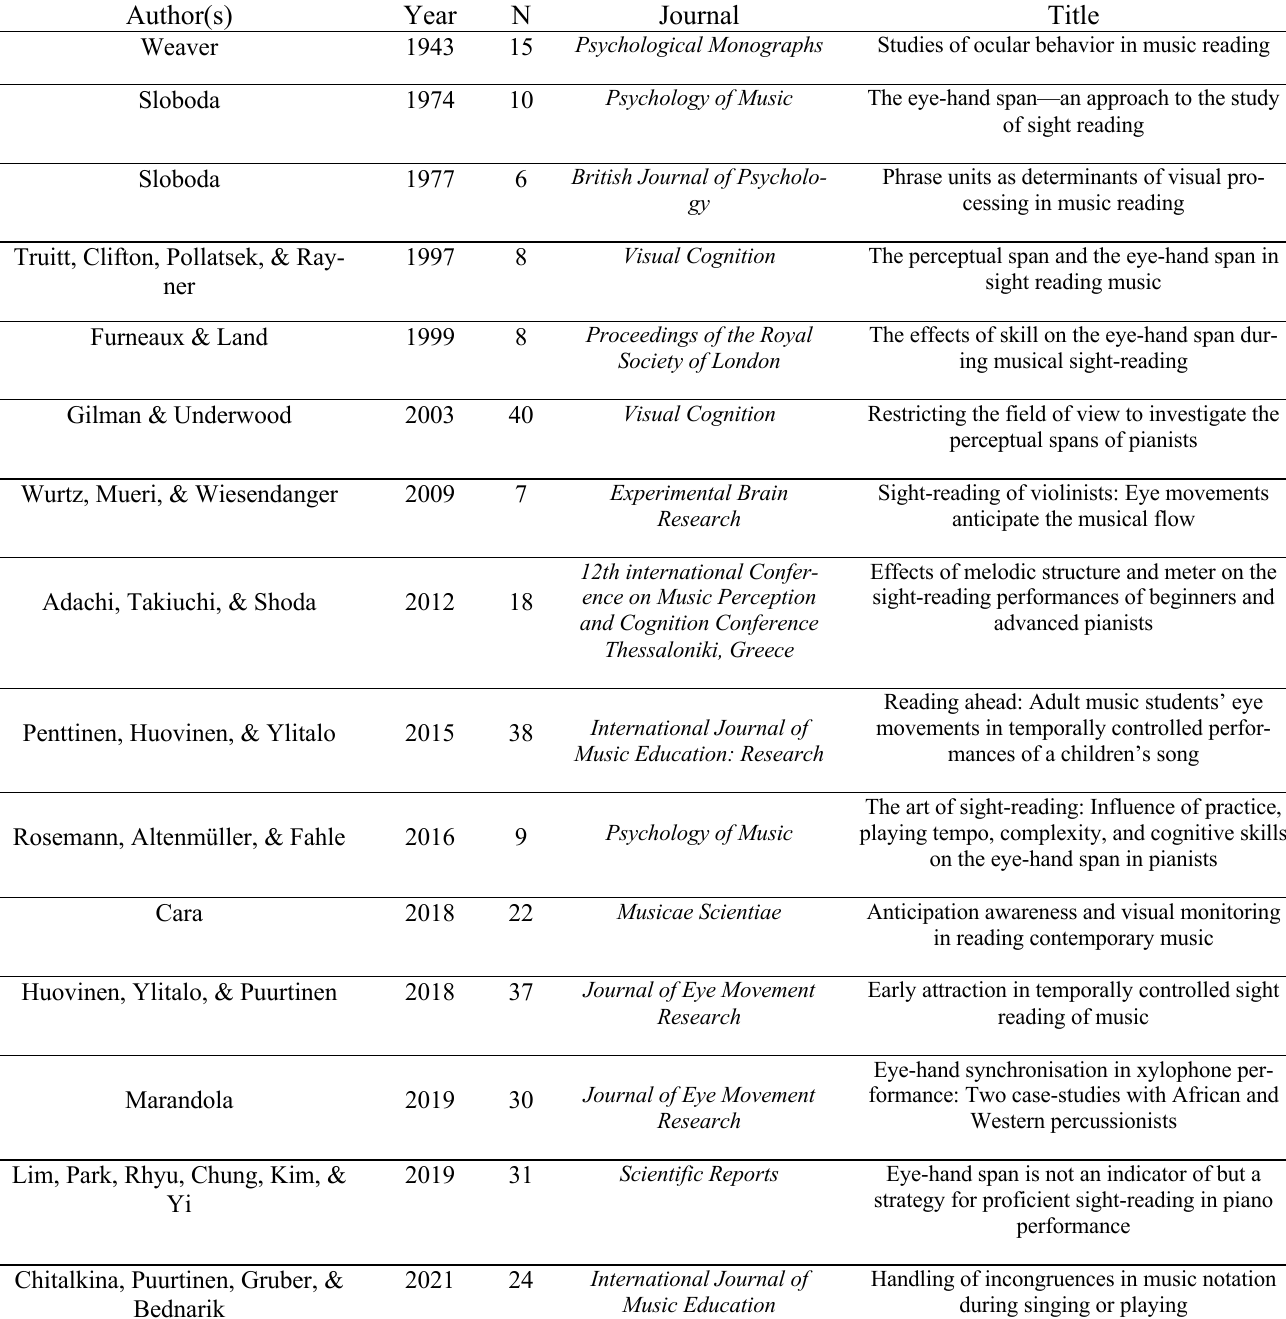
Table 1. Selected papers: peer-reviewed scientific journal articles on eye-hand span in music reading published in English since 1943